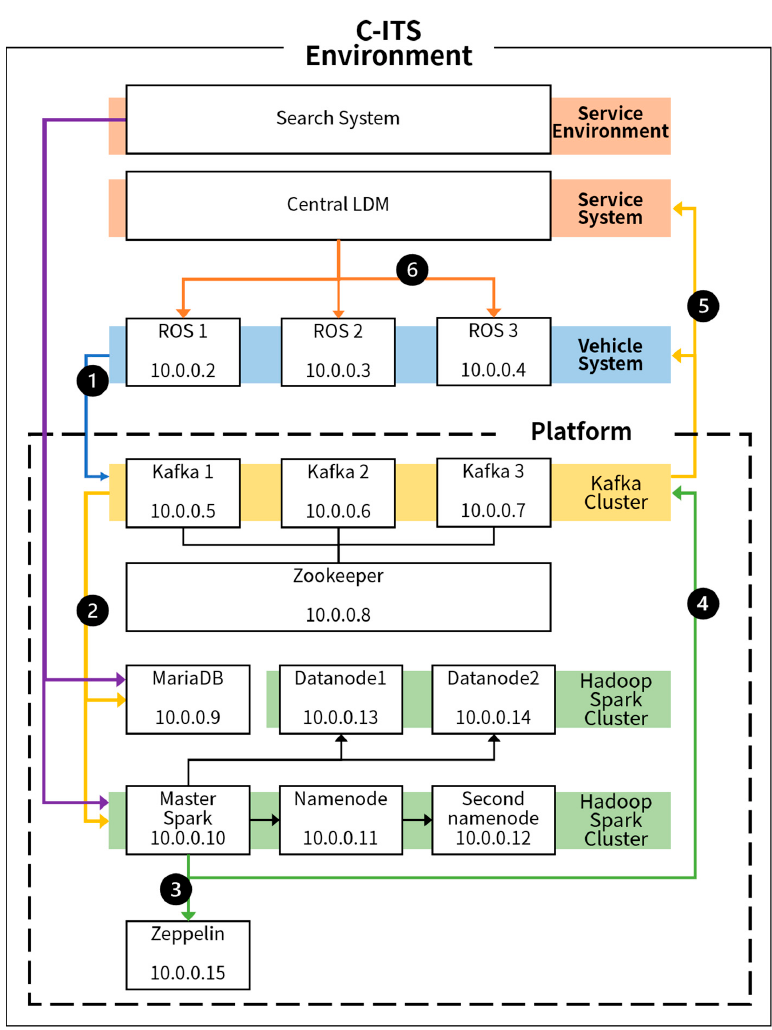
Figure 10. Implementation of the proposed C-ITS environment.